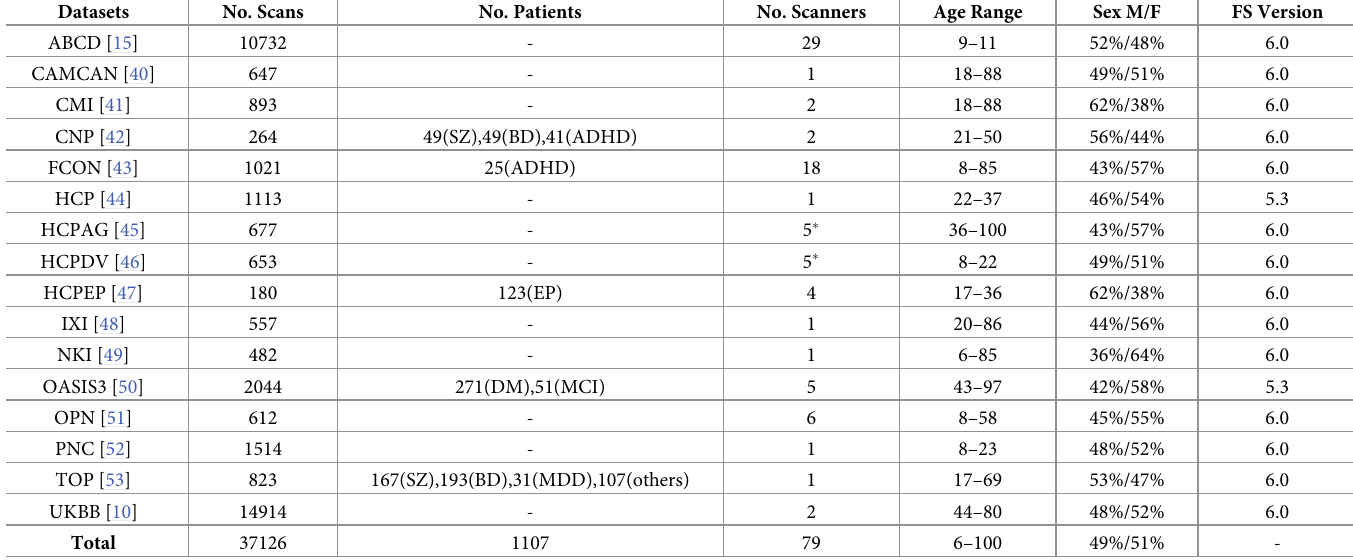
Table 1. Demographics of multi-site experimental data. ( � ) The HCPDV and HCPAG datasets are collected by the same data acquisition centers. We consider this in computing the total number of scanners in data.